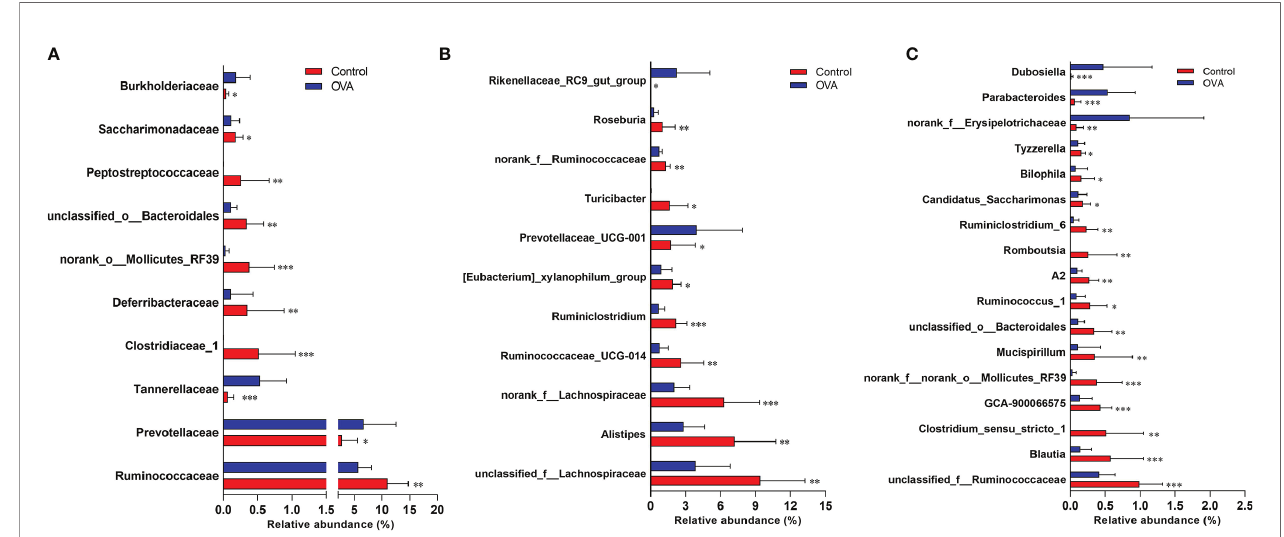
FIGURE 7 | Comparisons of relative abundance of main bacterial populations at the family (A) and genus (B, C) levels. The bar charts indicate the percentages of bacteria with Mean + SD (n=12/group). *p ≤ 0.05; **p ≤ 0.01 and ***p ≤ 0.001 vs OVA-treated group; Statistical analyses were performed with Wilcoxon rank-sum